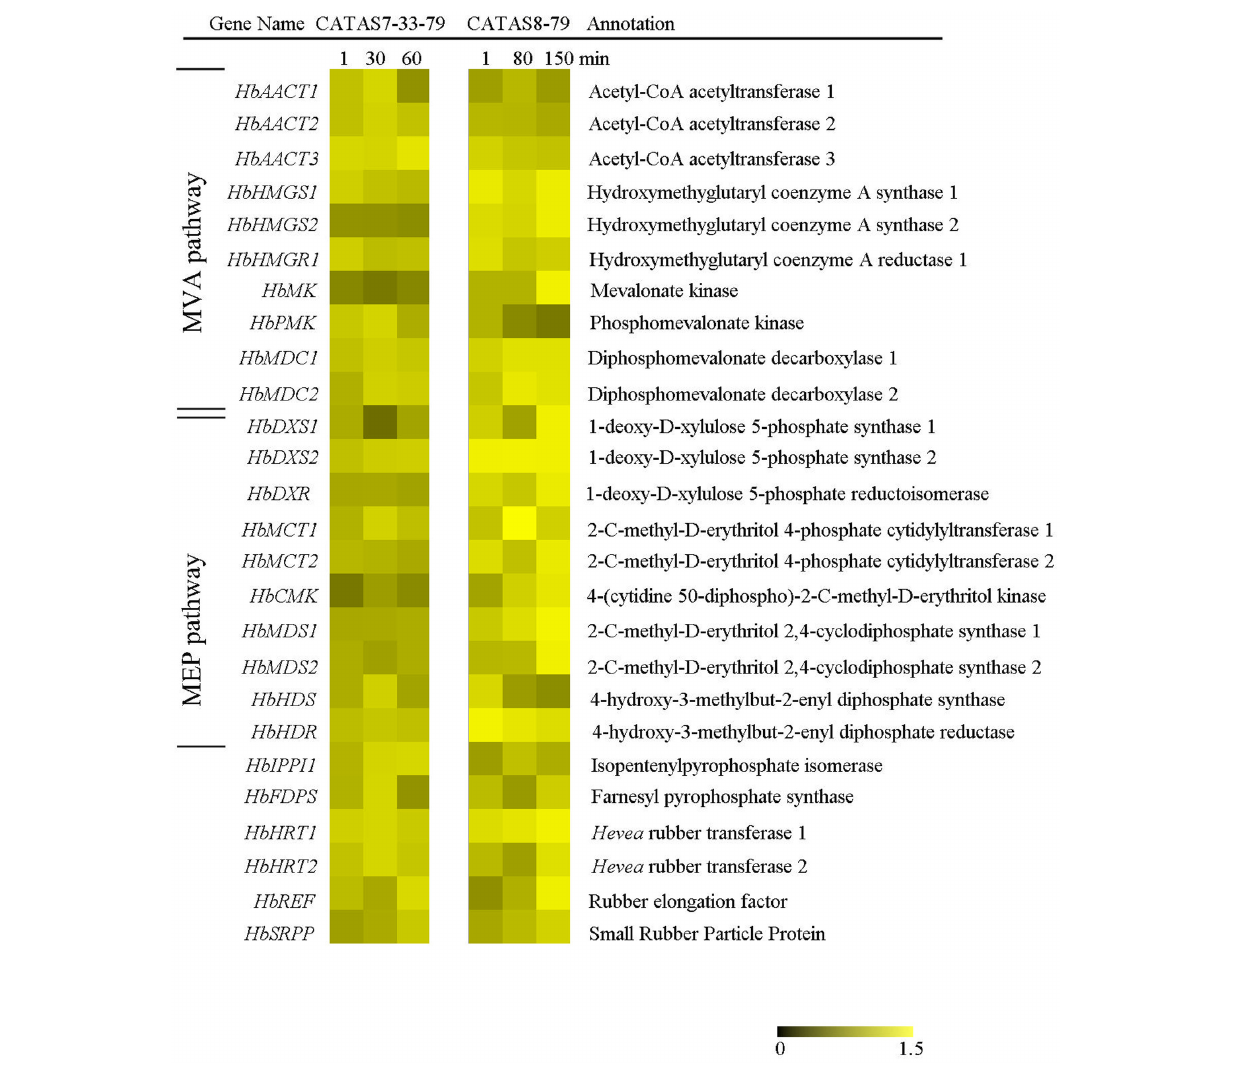
FIGURE 4 | The qRT-PCR analysis of natural rubber biosynthesis metabolism-related genes across three stages of latex flow between CATAS7-33-97 and